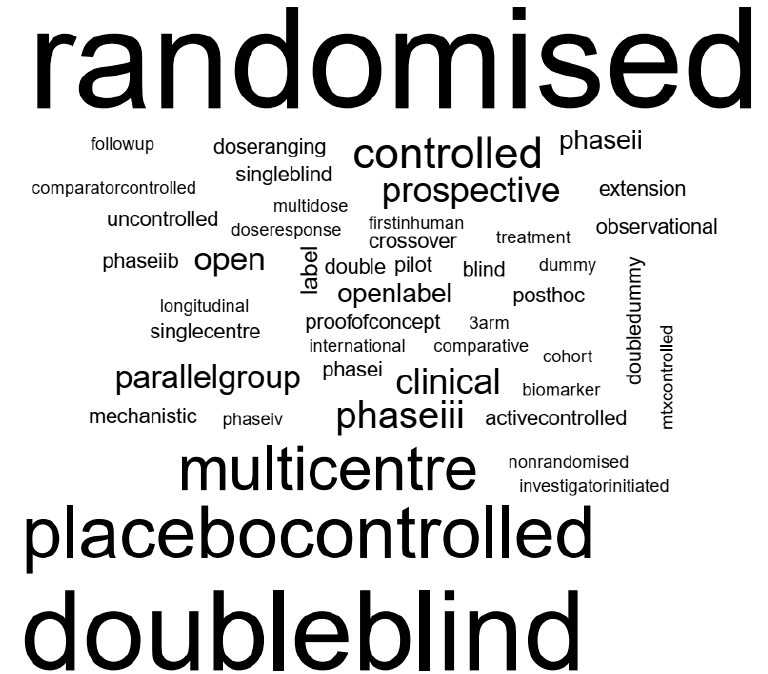
Figure 5. Impression of study design descriptions of the included human studies (word cloud). All text has been converted to lower-case and punctuation was removed (e.g., “Phase-III” now reads “phaseiii”). The most frequently used terms to describe human study design are: randomised (k = 329), double-blind (k = 248), placebo-controlled (k = 147) and multicentre (k = 113). Overall numbers of subjects per study (n) ranged from 8 to 283 for animal studies (median: 40), and from 8 to 2550 for human studies (median: 144). The number of experimental subjects